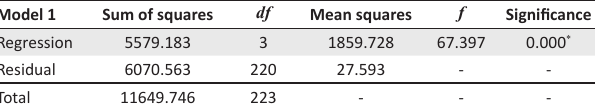
TABLE 4b: Regression analysis results: Analysis of variance Model 1